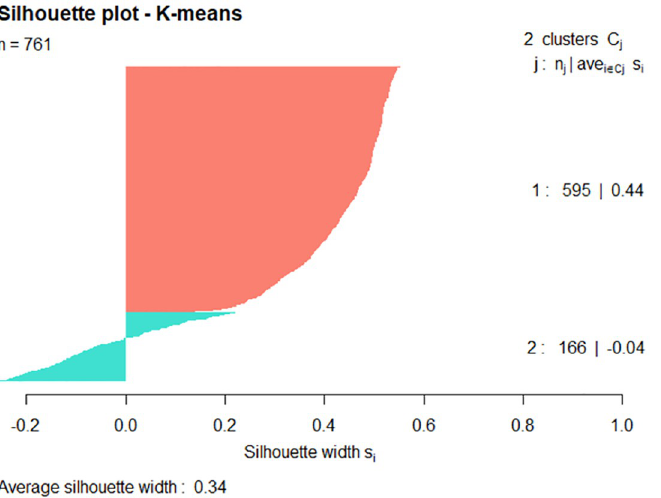
Fig 10. Silhouette plot of Nankeen Kestrel where k = 2.